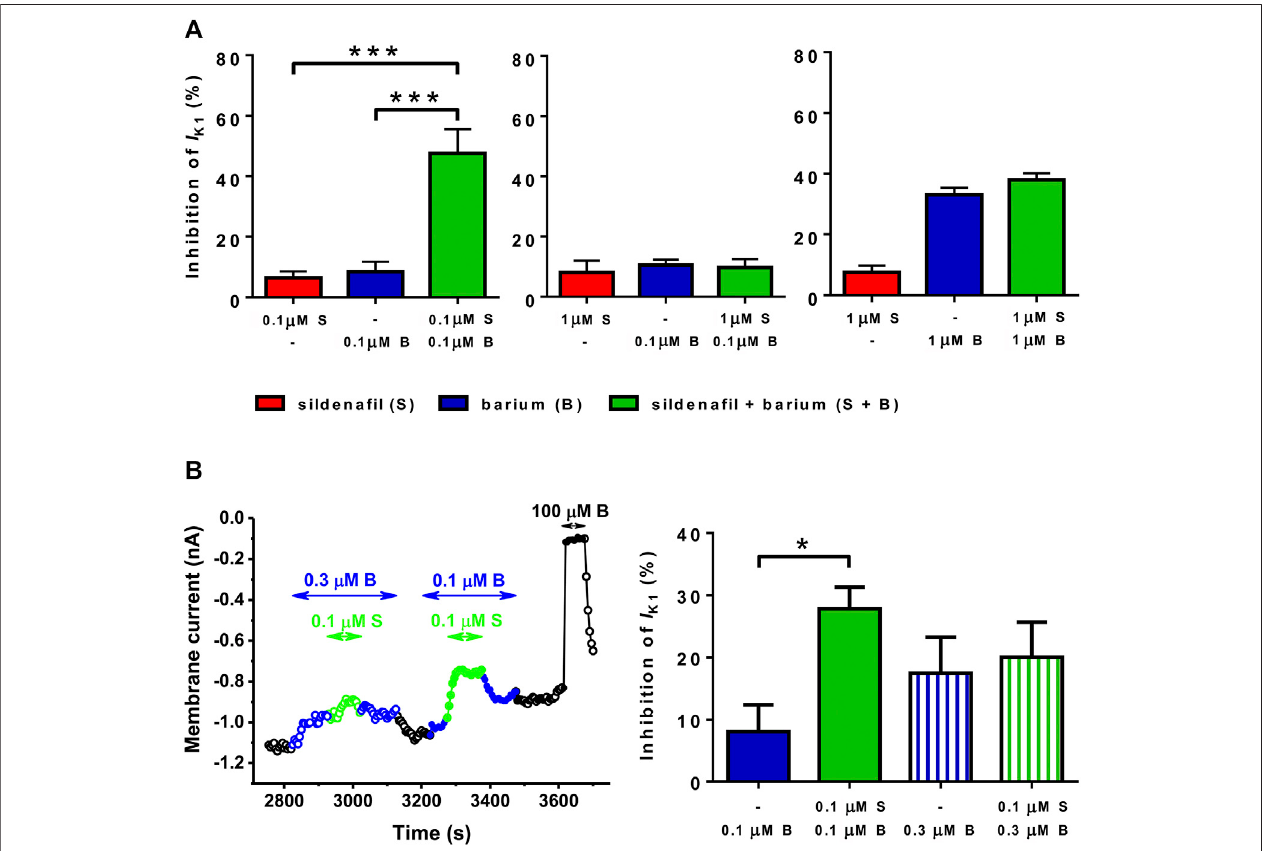
FIGURE4| Combinedactionofsildena fi l(S)andBa 2+ (B)atselectedconcentrations. (A) Thesynergybetweensildena fi landBa 2+ wasobservedonlyinthecaseof combination of 0.1 µM sildena fi l + 0.1 µM Ba 2+ ( n = 7 – 11/4 − 8); *** — statistical signi fi cance at p < 0.001. (B) Paired comparison of the effect of 0.1 µM Ba 2+ , 0.1 µM sildena fi l + 0.1 µM Ba 2+ , 0.3 µM Ba 2+ , and 0.1 µM sildena fi l + 0.3 µM Ba 2+ (left panel – representative recording; right panel – average data, n = 4/1); * — statistical signi fi cance at p <